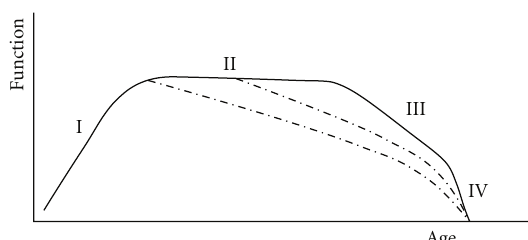
Figure 9: Idealized life trajectories of functional performance. Some functions (- - - -) decline earlier than others [33].